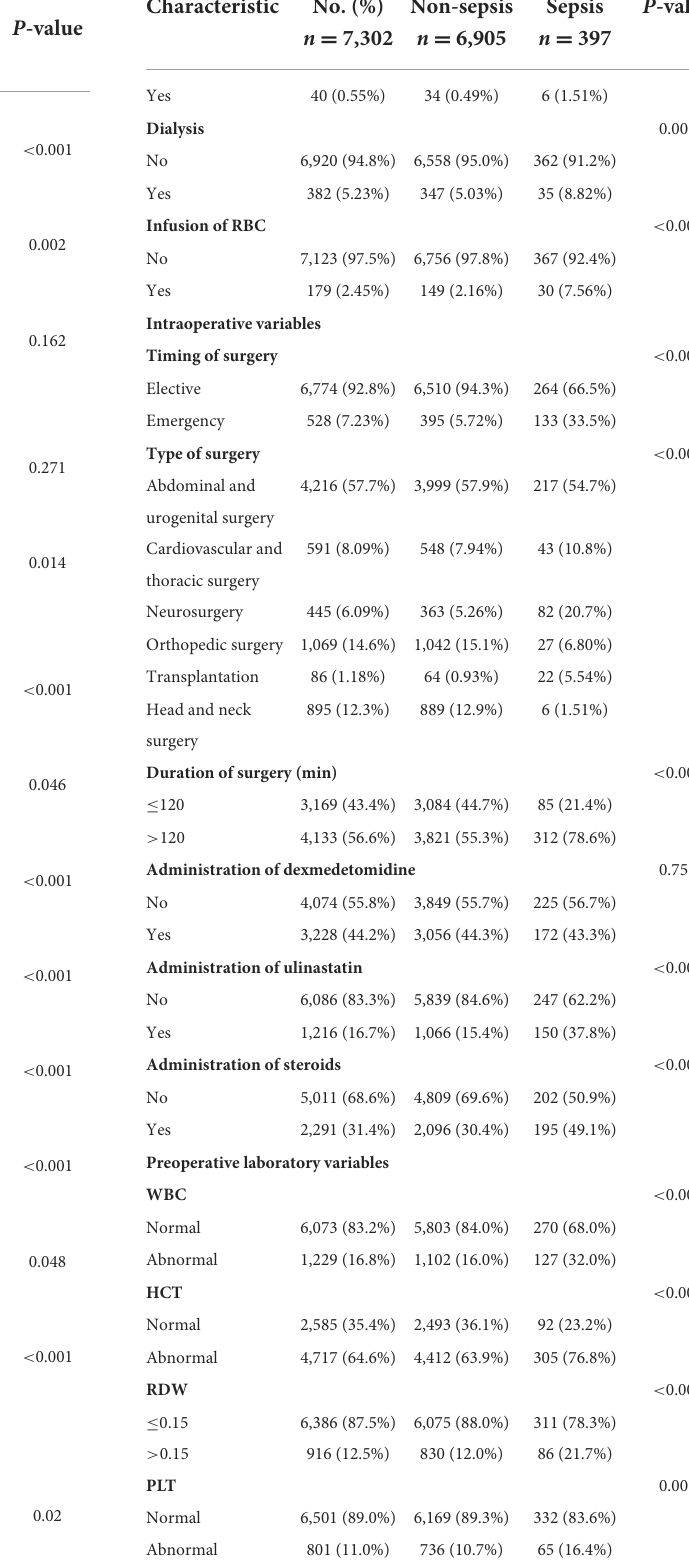
TABLE 1 Clinical characteristics of the patients with or without postoperative